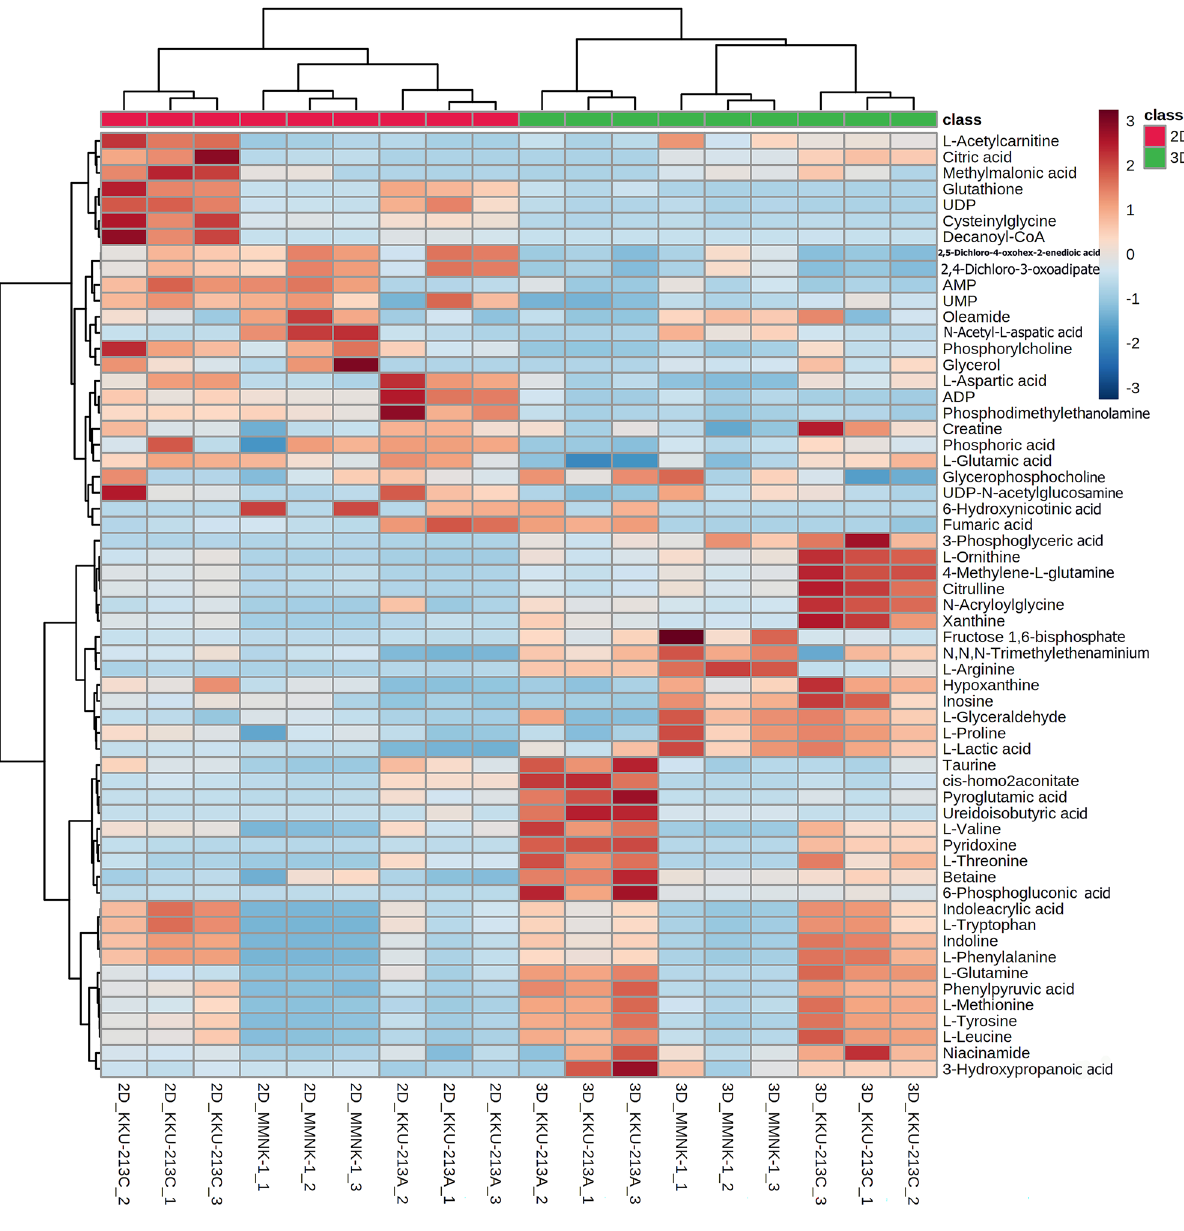
Figure 4. Heat map of differential metabolites of each cell line in 2D or 3D systems. Z-score hierarchical clustering based on Euclidean distance measure and Ward’s method for linkage analysis. Each row represents one of 59 metabolites, and each column represents one sample (culture system_cell line_experiment number). The color scale means the metabolite intensity standard deviations from the mean, with blue for low intensity and red for high-intensity levels. The figure was generated by MetaboAnalyst 5.0 (https:// www. metab oanal yst. ca/) 21 using our own data as